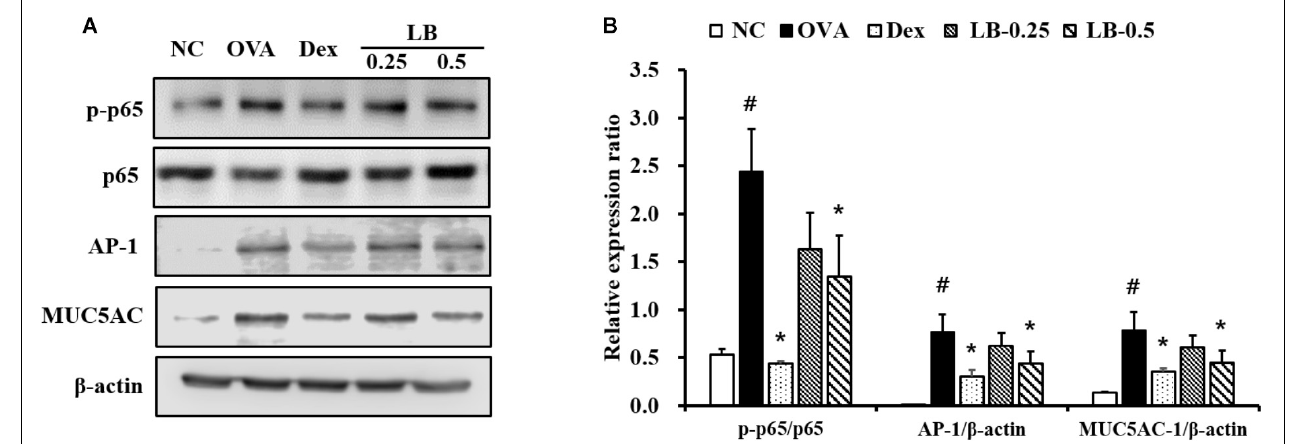
FIGURE 5 | Effects of lobeglitazone (LB) on the expression of NF- κ B, AP-1 and MUC5AC expression of lung tissue from OVA-challenged animals. (A) Gel images showing protein expression. (B) Relative expression ratio of protein. NC, normal control mice; OVA, OVA-sensitized/challenged mice; Dex, dexamethasone (3 mg/kg) + OVA-sensitized/challenged mice; LB-0.25 and –0.5, LB (250 µ g/kg or 500 µ g/kg, respectively) + OVA-sensitized/challenged mice. Values are expressed as mean ± SD ( n = 6/group). # Significantly different from NC, P < 0.05. ∗ Significantly different from OVA, P <